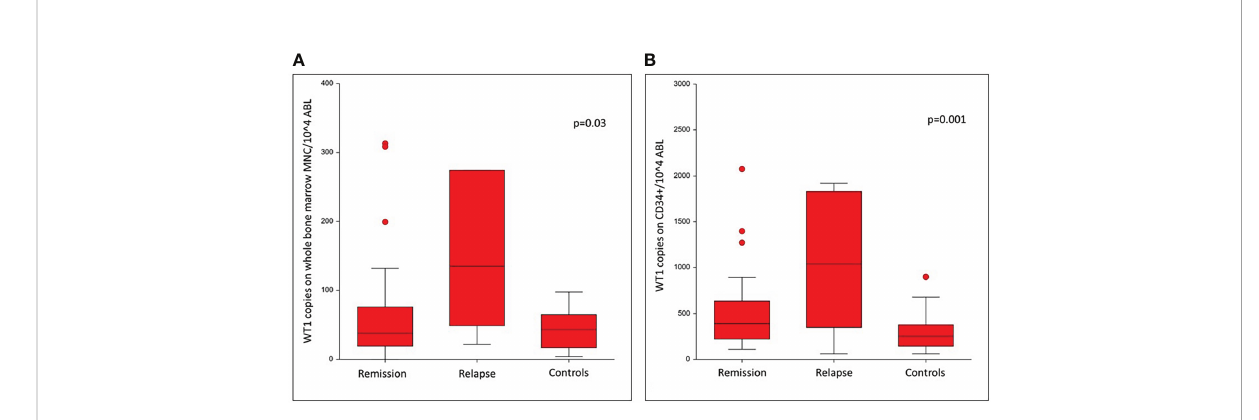
FIGURE 1 Comparison of WT1 levels on day +60 after allogeneic HSCT for patients in remission, patients relapsed and in